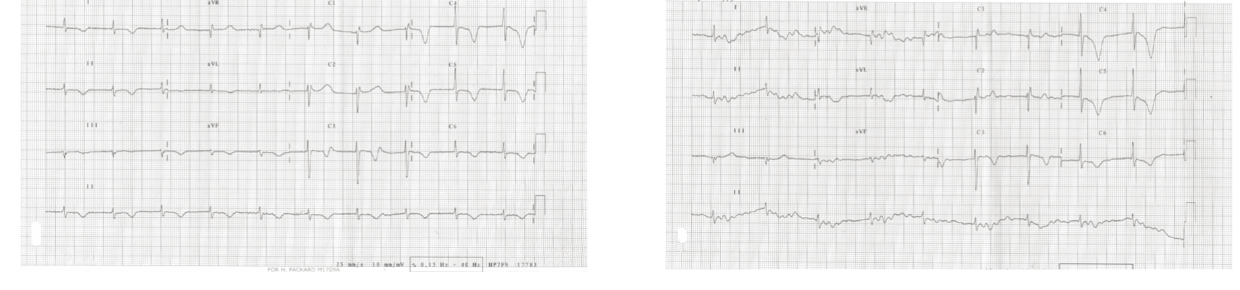
Figure 1: The electrocardiogram showed atrial fibrillation. The QT interval was markedly prolonged.